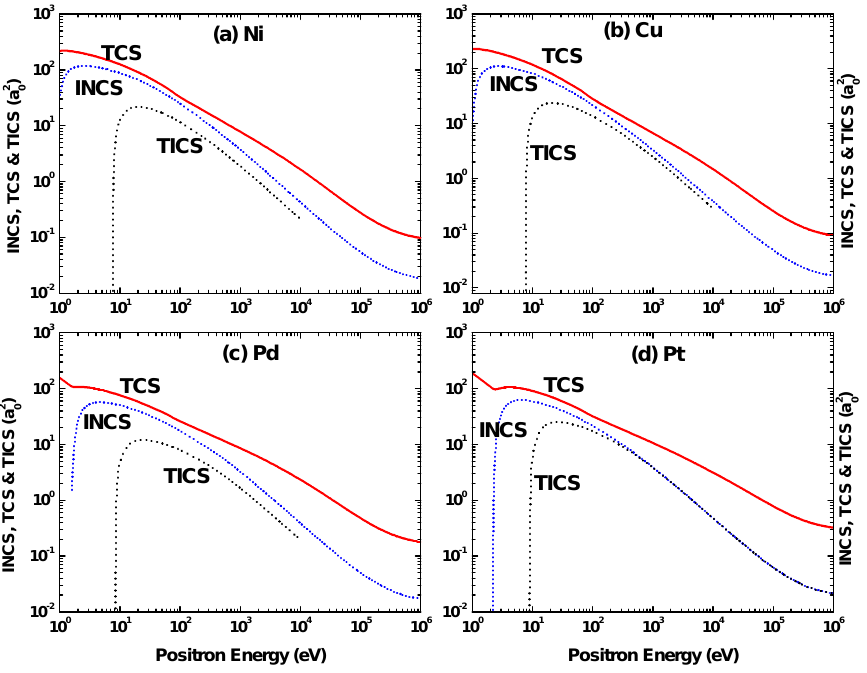
Figure 39. The present OPM calculations of the INCS, TCS, and TICS for positron impact scattering from ( a ) Ni 58 , ( b ) Cu 63 , ( c ) Pd 108 , and ( d ) Pt 196